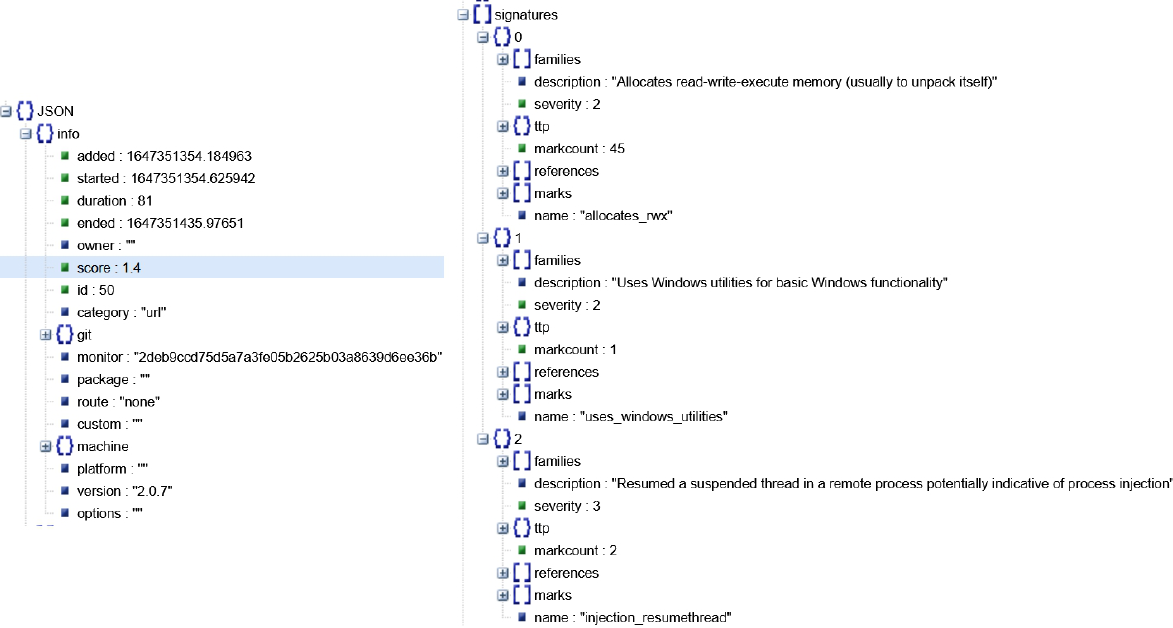
Figure 9. Output after URL analysis by Cuckoo